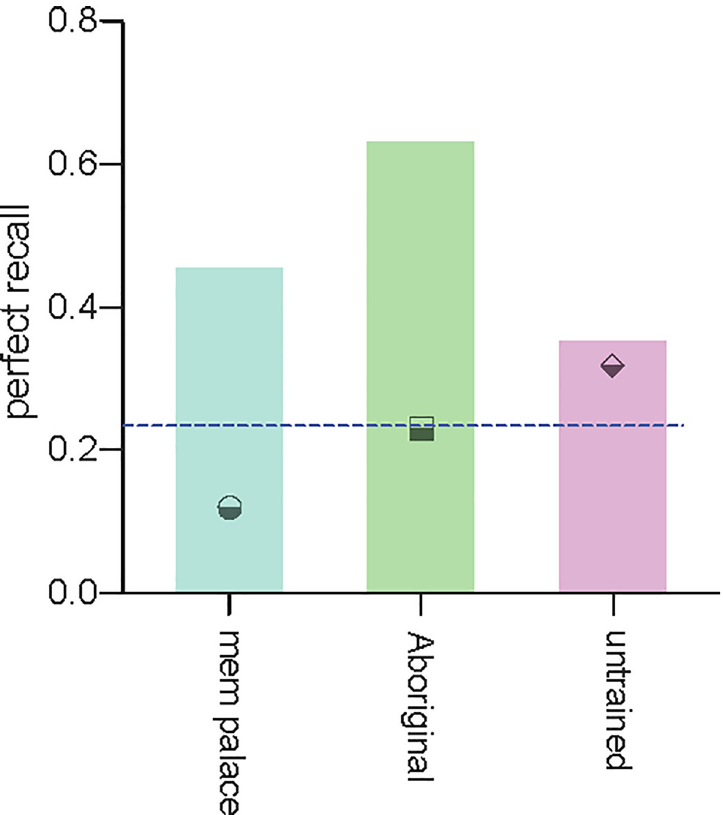
Fig 3. Graphical summary of the observed increase in participants’ likelihood of obtaining the maximum recall score following training. Blue dashed line indicates the number of participants (17/76, 22%) who achieved a recall score of 20/20 at the baseline test (prior to training). Odds ratios of improving to 20/20 performance at the first post- training recall test are shown as numerical values within the bars for each study group. Symbols indicate the fraction of participants in each randomized group who obtained 20/20 at baseline (3/25 in the memory palace group; 6/26 in the Australian Aboriginal method group; and 8/25 in the untrained recall group.